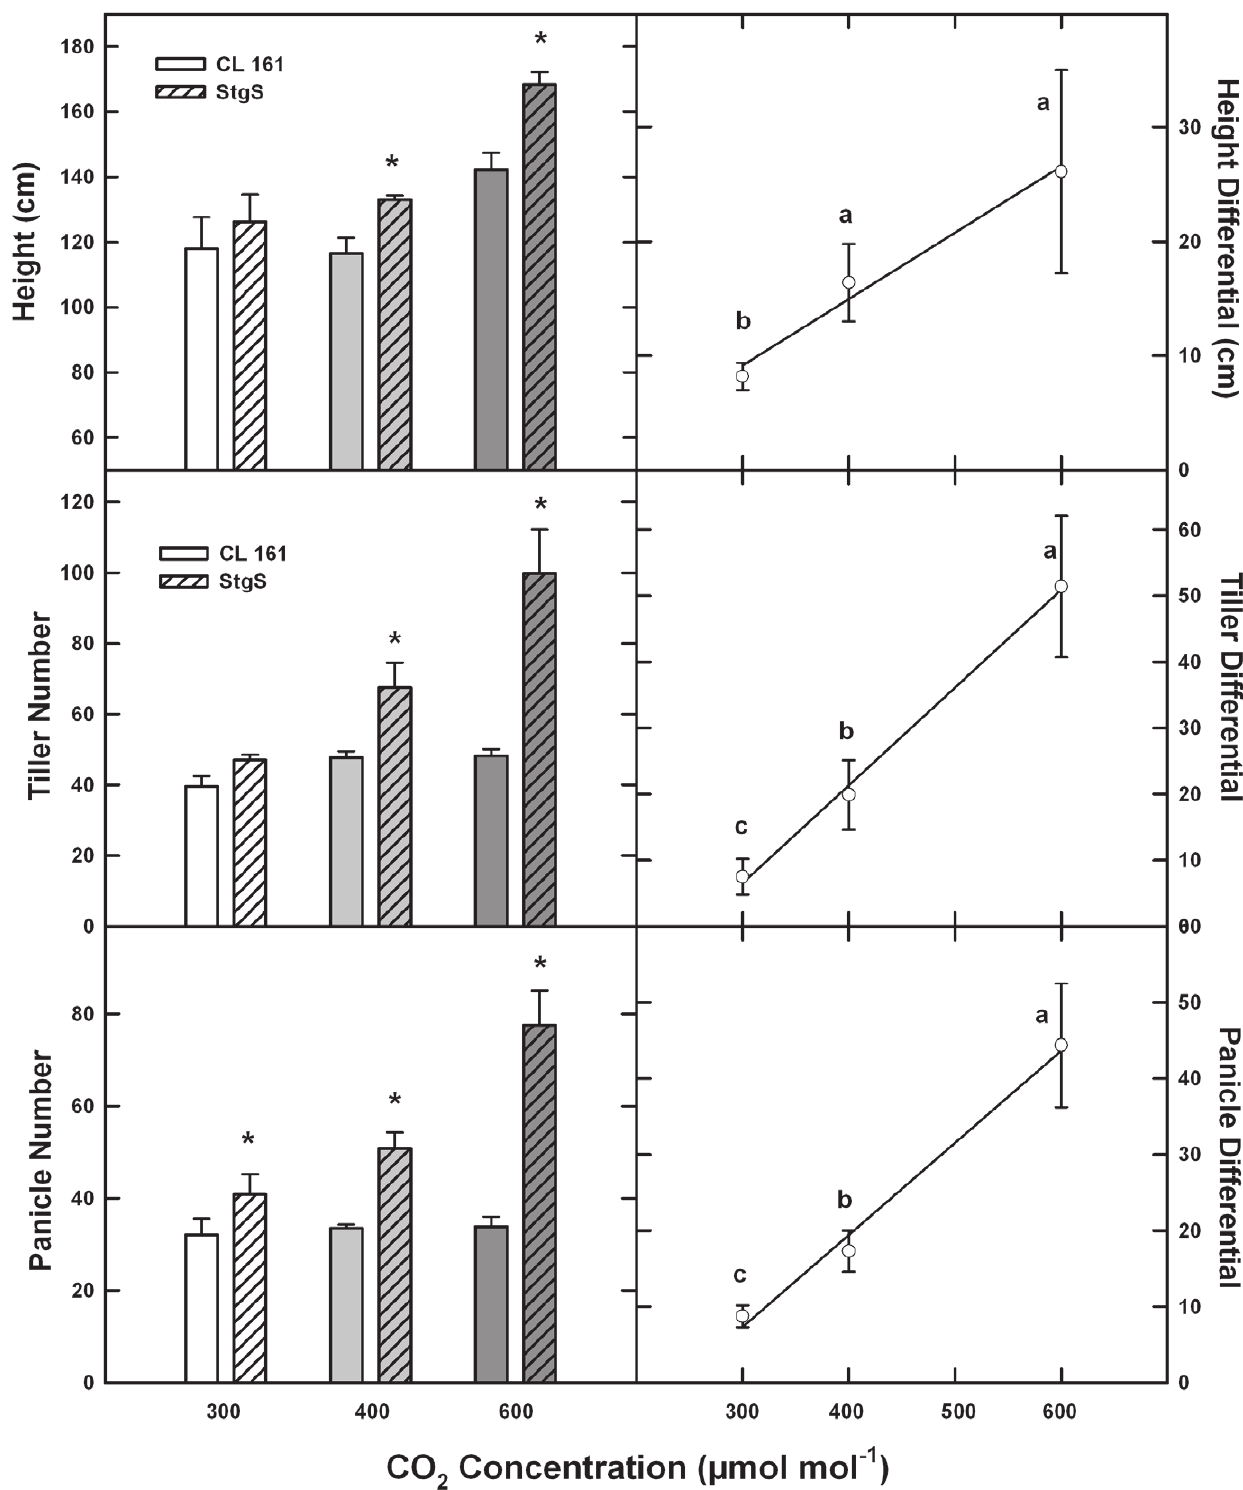
Figure 1. Relative change in morphological parameters (per plant) that influence reproductive onset and outcrossing as a function of recent and projected increases in CO 2 concentration ( m mol mol 2 1 ) for a wild and cultivated rice population. * indicates a significant difference at the P , 0.05 level as a function of a given CO 2 concentration between populations; different letters indicate a significant difference in the degree of CO 2 enhancement for the measured parameter (e.g. height). Bars are 6 SE.